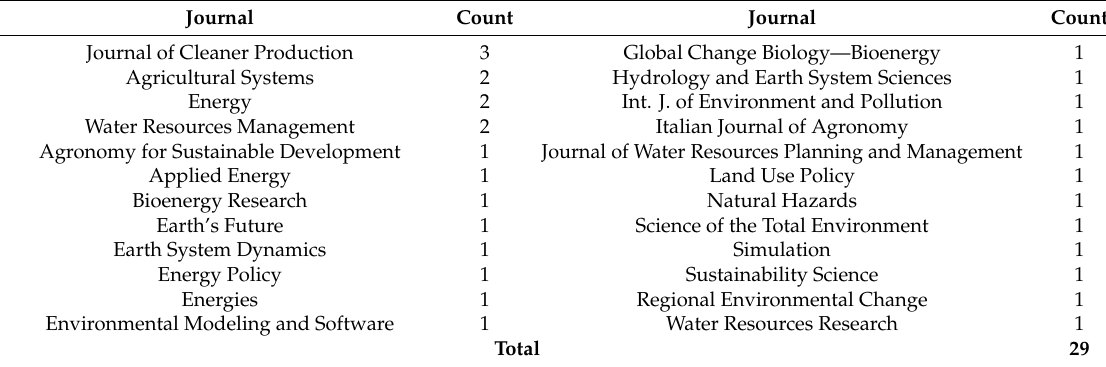
Table A1. Journals in which reviewed agent-based models were